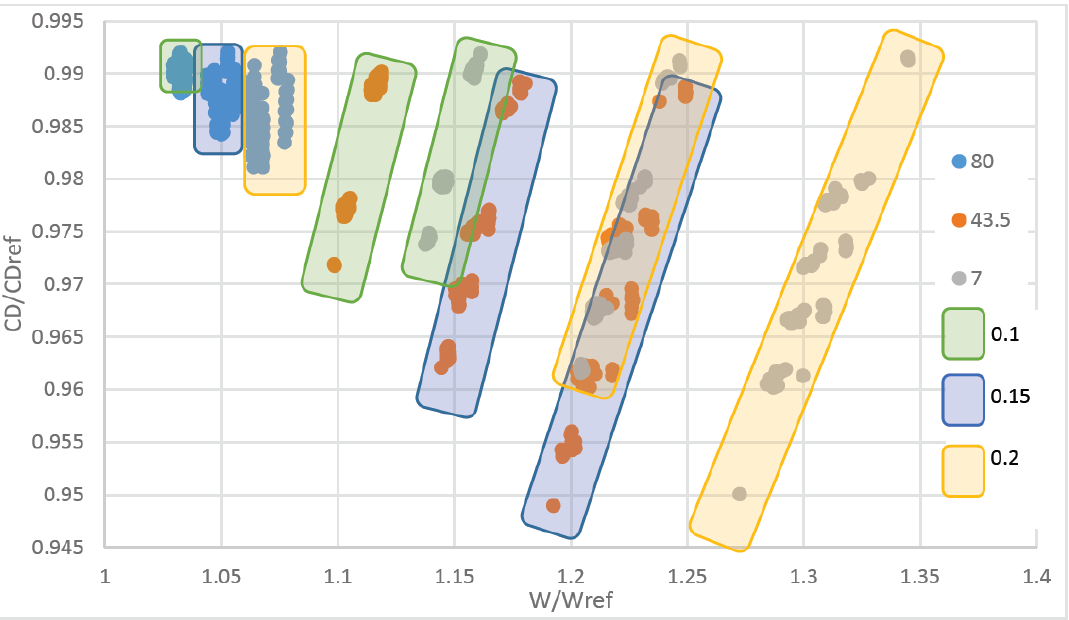
ff ect on design point Figure 11. Winglet span effect on design point distribution. Figure 11. Winglet span e